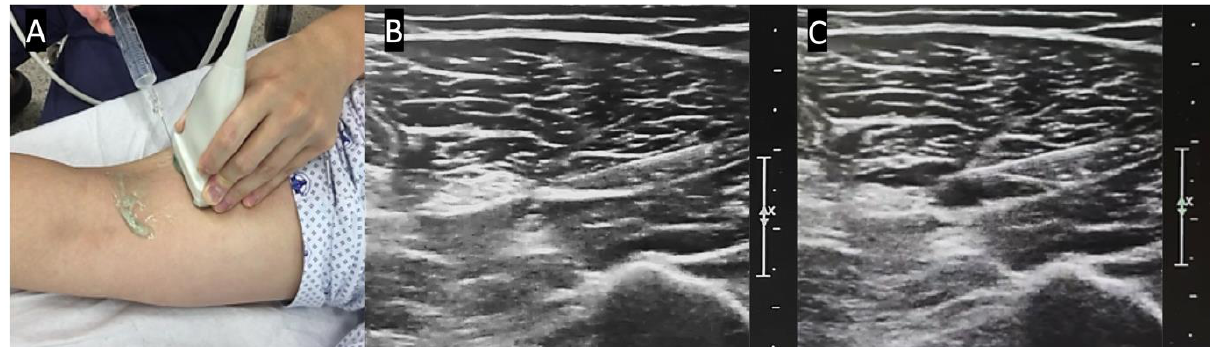
Figure 1. The popliteal block was performed under real-time ultrasound guidance. ( A ) From the popliteal crease, the tibial nerve was traced proximally along the posterior thigh. ( B ) The target of injection was chosen just proximal to the bifurcation point of the sciatic nerve. A needle was placed with a short-axis, in-plane, and lateral side approach to the sciatic nerve. ( C ) After confirming the needle tip position, subparaneural injection was performed with 15 mL of 1% lidocaine.